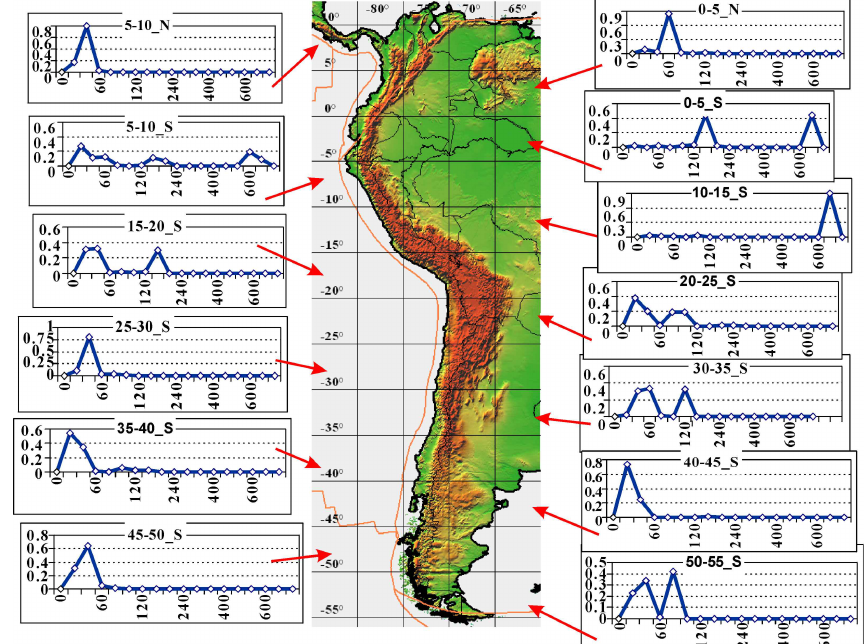
Fig. 7. The distributions of the EQ energy released in depth in each latitudinal belt (size 5 ◦ ) are shown in 13 plots. The horizontal axes are depth in km; the vertical axes are relative value of the released energy (normalization by total value of energy released in given latitudinal belt). The red arrows indicate on the correspondent latitudinal